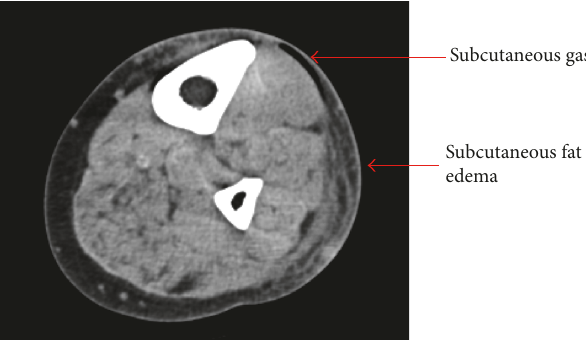
Figure 2: CT scan of the left lower extremity is displayed. Small amount of gas and subcutaneous fat edema present in anterior and lateral